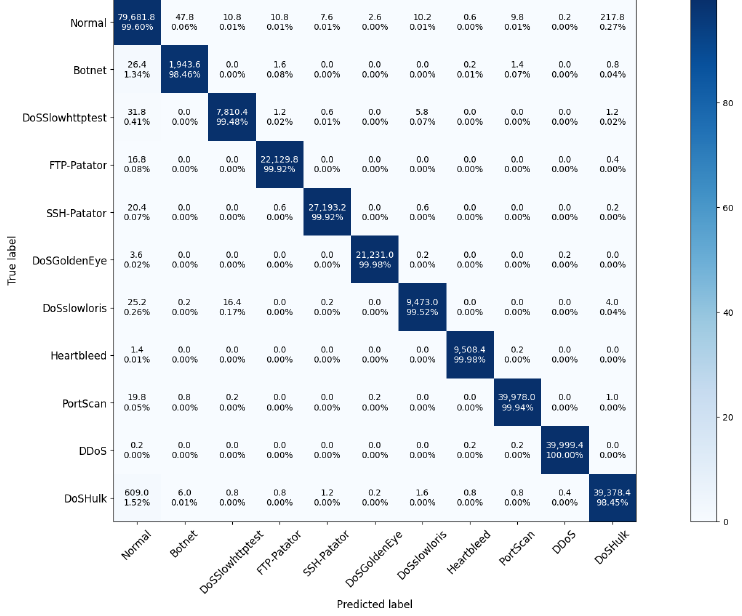
Figure 4. The experiment results of the multi-class